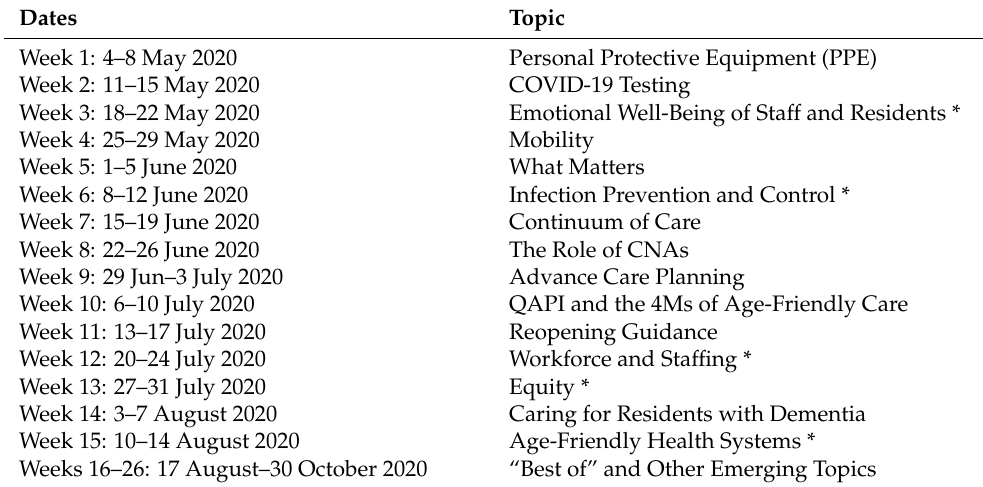
Table 2. RRN huddle topics by week (May–October 2020).